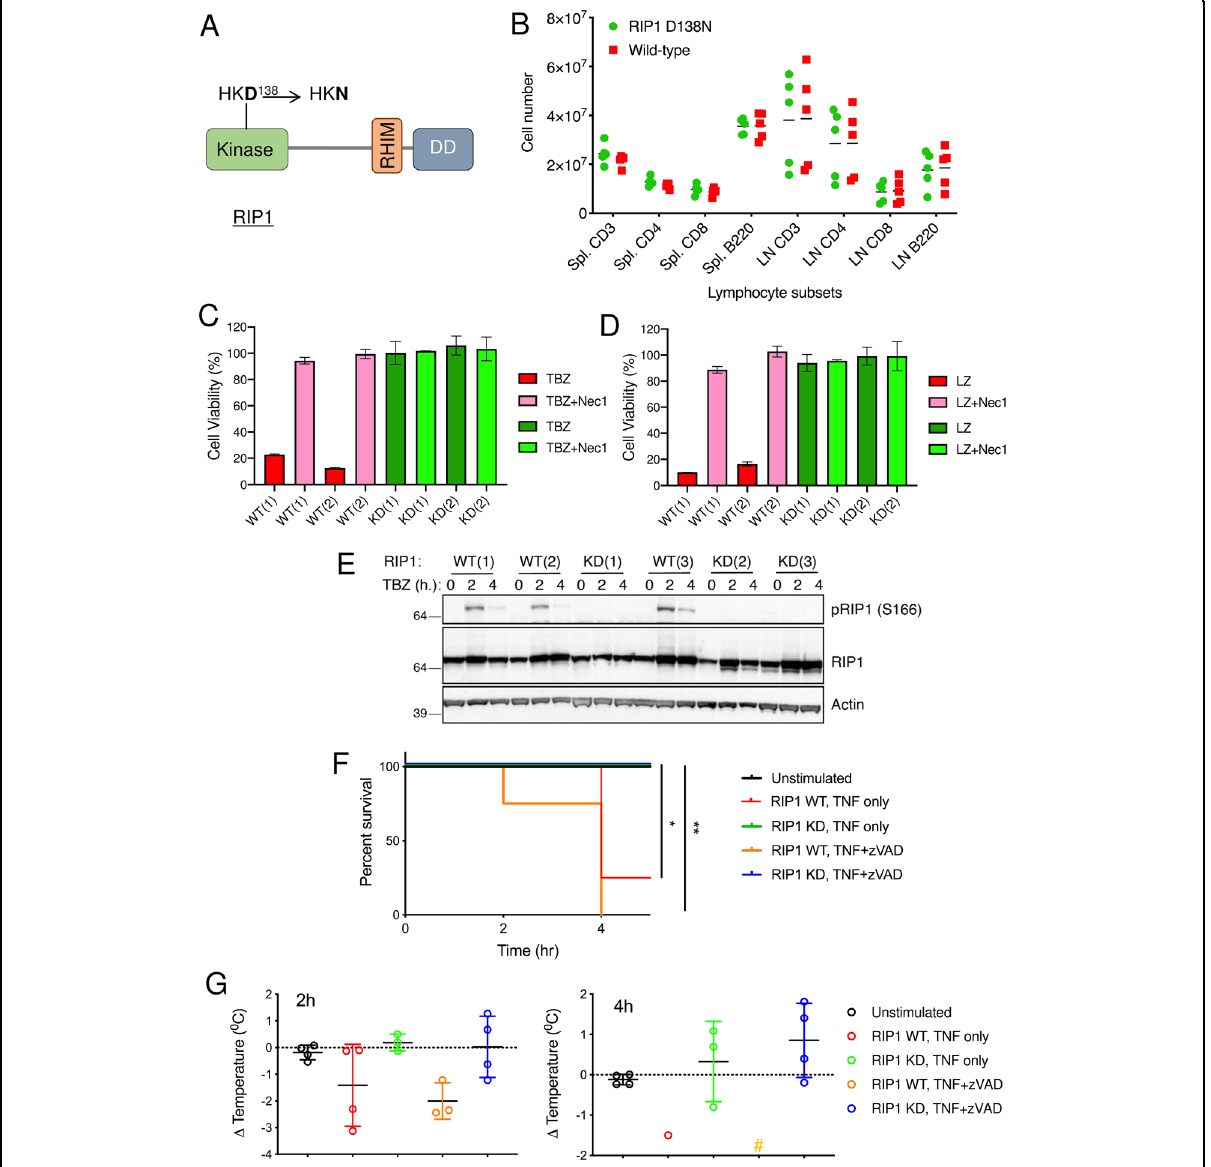
Fig. 1 RIP1 KD rats and cells are resistant to necroptotic cell death and TNF driven hypothermia. A Schematic depiction of D138N kinase- inactivating mutation in rat RIP1. B Lymphocyte subsets from spleen (Spl) and lymph nodes (LN) of RIP1 KD and WT rats. Data from individual rats of each genotype ( n = 5) are plotted, with the mean value for each group indicated by a horizontal line. There were no signi fi cant differences between two genotypes as evaluated by unpaired t -test ( p > 0.1). C , D BMDMs derived from WT and RIP1 KD rats were treated with TNF, BV6, and zVAD (TBZ) ( C ) or LPS and zVAD (LZ) ( D ) with or without Nec1 overnight. Cell viability was assessed by Cell Titer-Glo assay. Numbers in parentheses indicate that cells were derived from different animals. E BMDMs derived from WT and RIP1 KD rats were treated with TBZ for indicated periods of time. Cellular lysates were immunoblotted with the indicated antibodies. Numbers in parentheses indicate that cells were derived from different animals. F , G WT and KD RIPK1 rats were treated with TNF (300 µg/kg) and zVAD 10 mg/kg or PBS (unstimulated) for 4 h. Survival ( F ) and body temperatures ( G ) were evaluated 2 and 4 h after treatment. * p < 0.05 and ** p < 0.01 between WT and RIP1 KD by Mantel – Cox test. # in ( G ) indicates that no animals from this group survived to this time point. Data are represented as mean ±